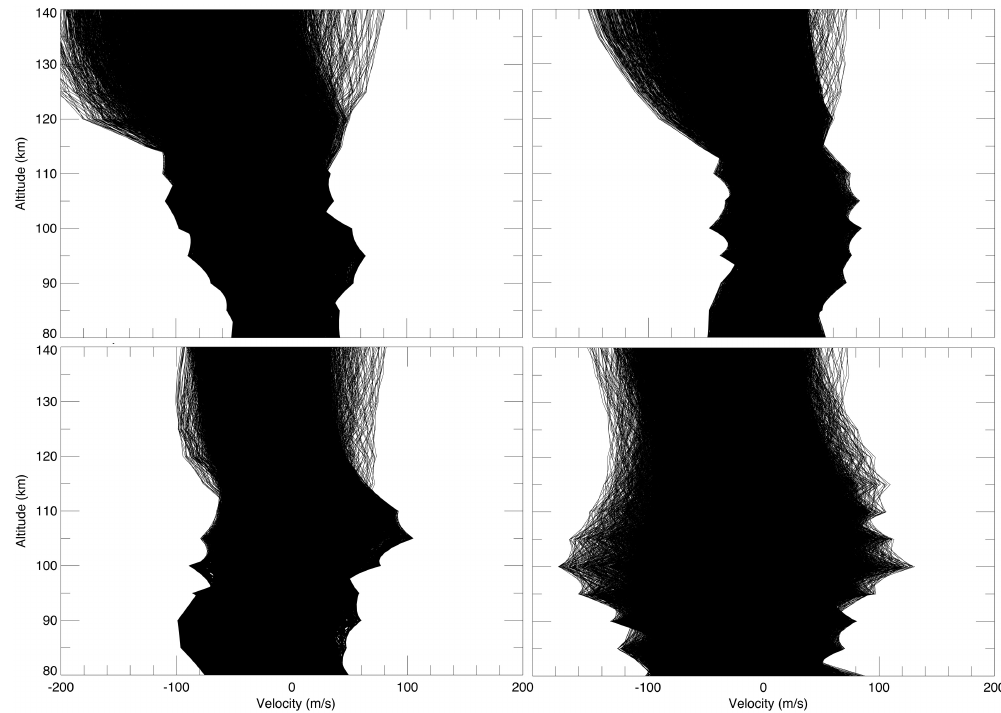
Fig. 6. Superposition of wind profiles for all TIME-GCM grid points between 52.5 ◦ S and 52.5 ◦ N for four different model runs. The top left panel shows the results with constant solar and geomagnetic forcing. The top right panel shows the results for variable solar and geomagnetic forcing. The lower left panel shows the curves when NCEP forcing is included at the 30-km lower boundary of the model. The lower right panel shows the profiles obtained when the model height resolution is